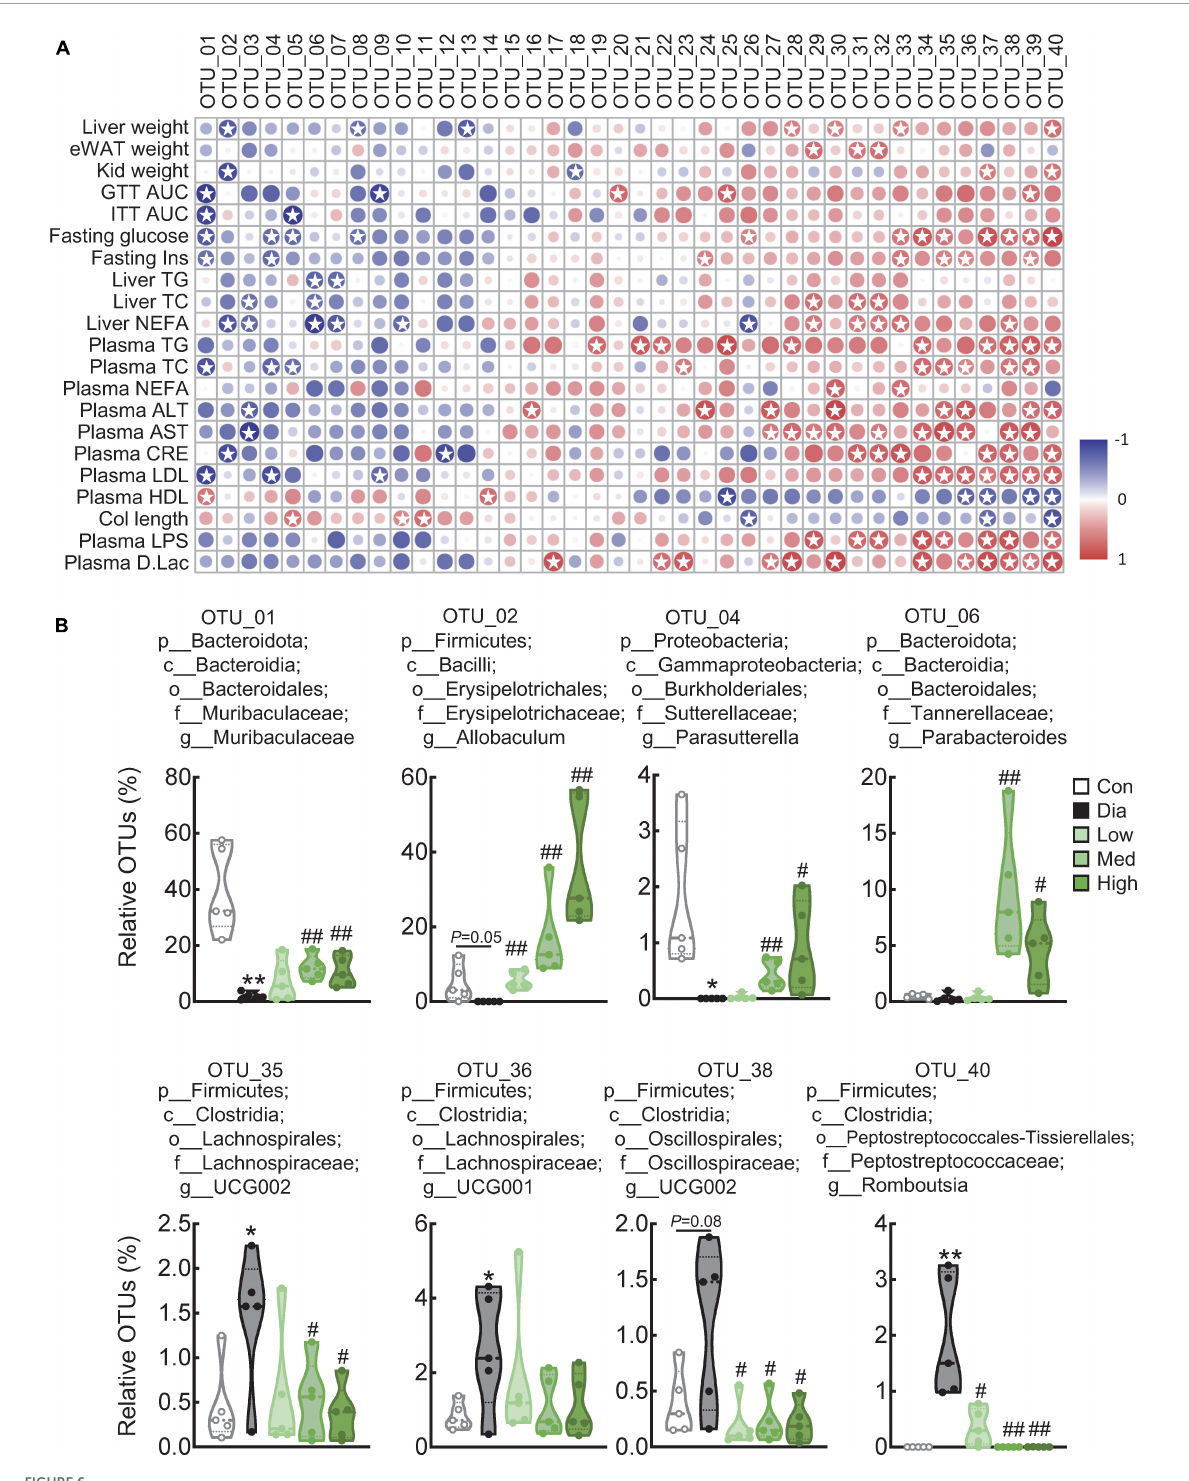
FIGURE6 Correlation analysis of top 40 genera with diabetes-related parameters. (A) Correlation analysis of top 40 genera with diabetes-related parameters between the control, diabetic, and high-dose CFP-treated mice. Rows correspond to diabetes-related parameters, and columns correspond to the specific genus. Red and blue colors denote positive and negative associations, respectively. The intensity of the colors represents the degree of association between the abundance of bacteria and host parameters assessed by Pearson correlation analysis. Stars means P < 0.05. (B) Relative abundances of Muribaculaceae , Allobaculum , Parasutterella , Parabacteroides , Romboutsia , Oscillospiraceae UCG 002 , Lachnospiraceae UCG 001 , and Lachnospiraceae UCG 002 in the feces. Data are presented as the means ± SEM, * P < 0.05, ** P < 0.01 vs. control; # P < 0.05, ## P < 0.01 vs.